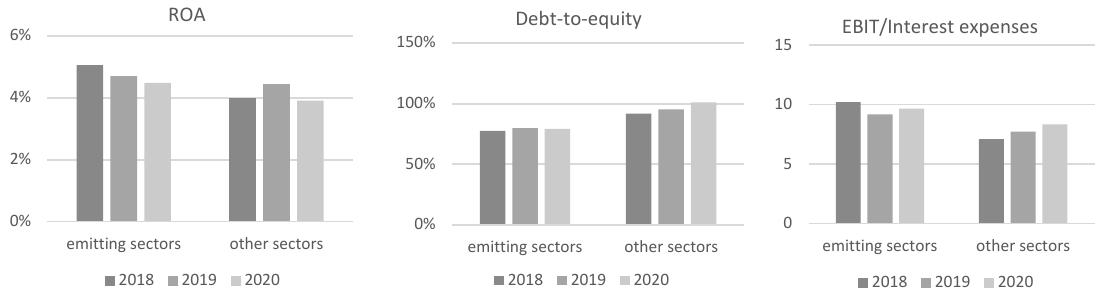
Figure 5. Financial performance measures: emitting sectors versus other sectors.